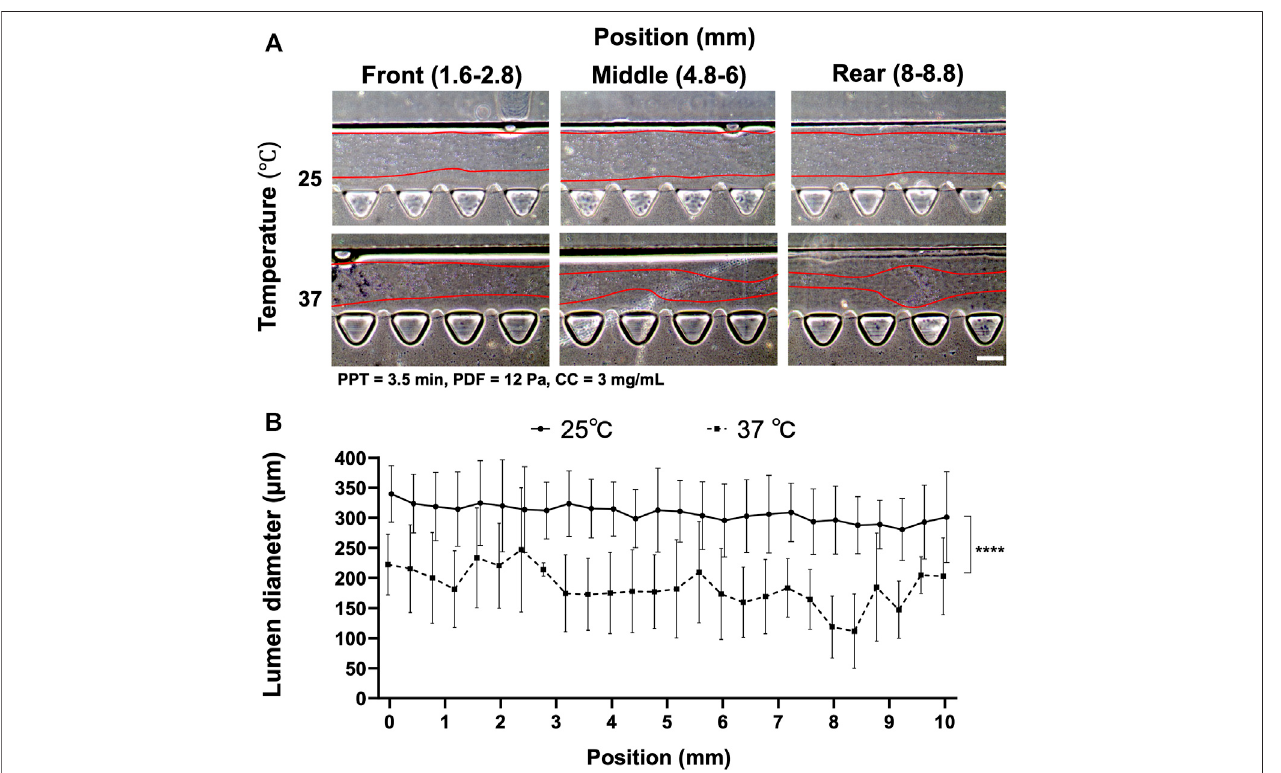
FIGURE2| Comparison ofthecollagenlumen formedat 25 ° Cor37 ° C,wherepressure-driven fl ow(PDF)applied undervolume difference betweeninlet andoutlet at 12 Pa, partial polymerization time (PPT) at 3.5 min, and collagen concentration (CC) at 3 mg ml − 1 . (A) Morphology of the collagen lumen at different locations of the media channel, i.e., front (1.6 – 2.8 mm), middle (4.8 – 6 mm), and back (8 – 8.8 mm) positions. (B) Quanti fi cation of the average collagen lumen diameter at different locations in the media channel pre-polymerized at RT and 37 ° C. Scale bar: 200